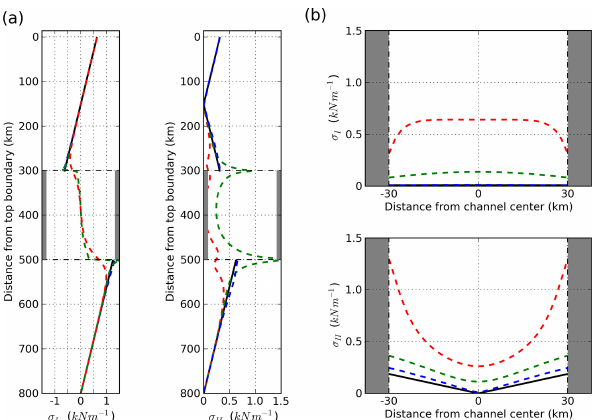
Figure 8. Stress invariants ( σ I , σ II ) along the transects of corre- sponding colors in Fig. 7: (a) transects running along the y direction and (b) transects running along the x direction. Solid black lines in- dicate the analytic solutions. The grey area indicates the position of the